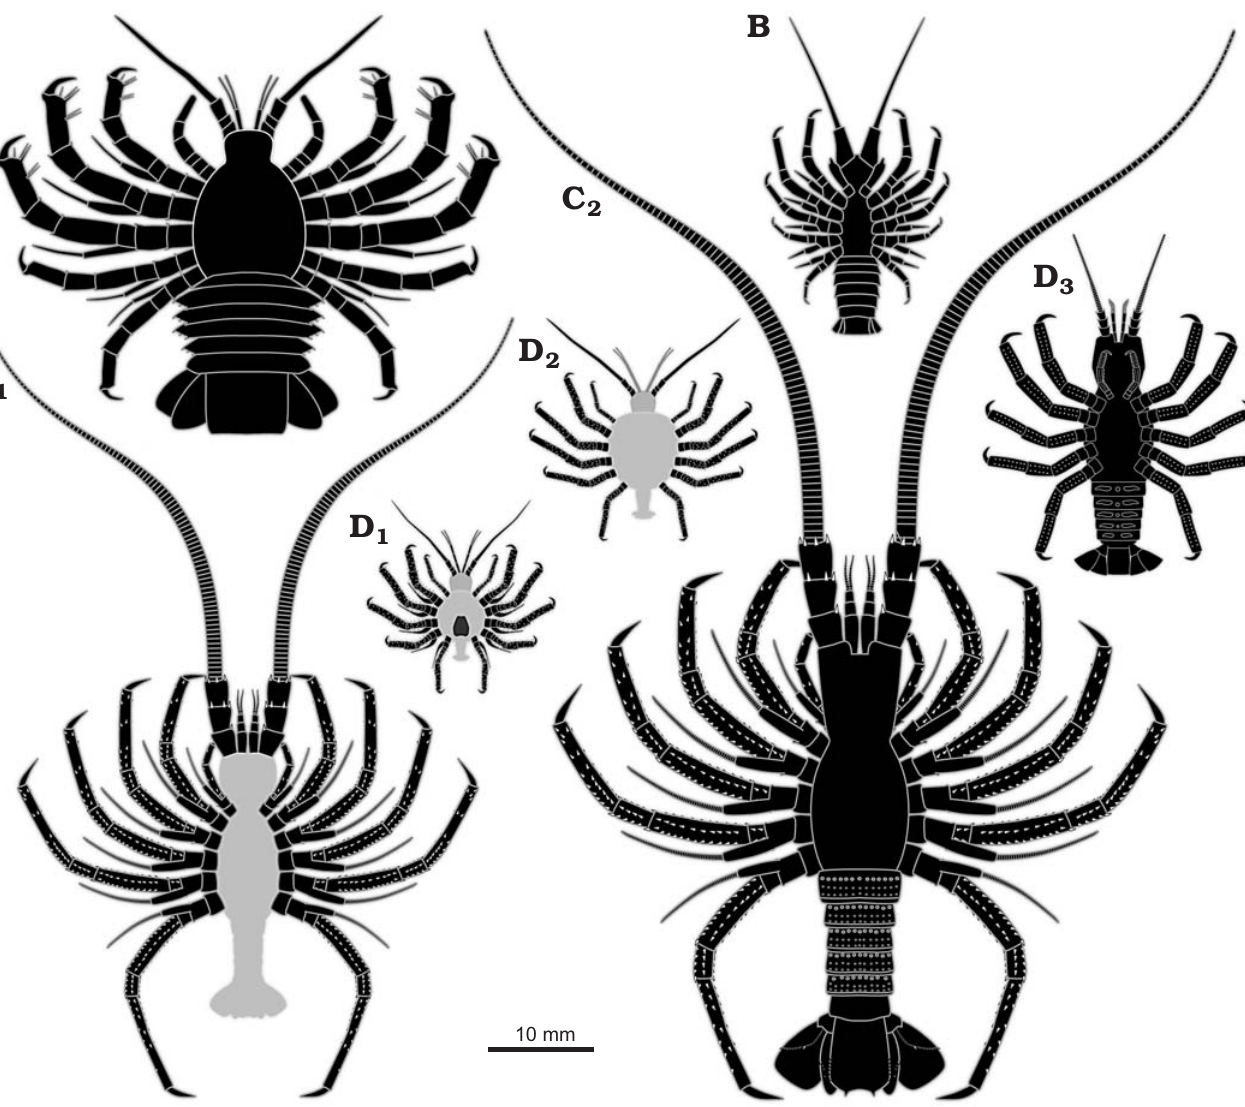
Fig. 3. Size comparison of different non-phyllosoma type achelatan larvae. All specimens as idealised restorations. The light grey areas represent body parts not being preserved, but inferred. A . Polzicaris sahelalmae (based on Haug et al. 2013a). B . SMNS 70449. C . “ Palinurina ” tenera , earliest (C 1 ) and largest (C 2 ) known stage (based on Haug and Haug 2016). D . Cancrinos claviger , earlier larva still possessing exopods (D 1 ), later larva with exopods already absent (D 2 ), possible juvenile, yet without triangular sternum (D 3 ) (D 1 , D 2 , based on Haug et al. 2013a; D 3 , based on Haug and Haug